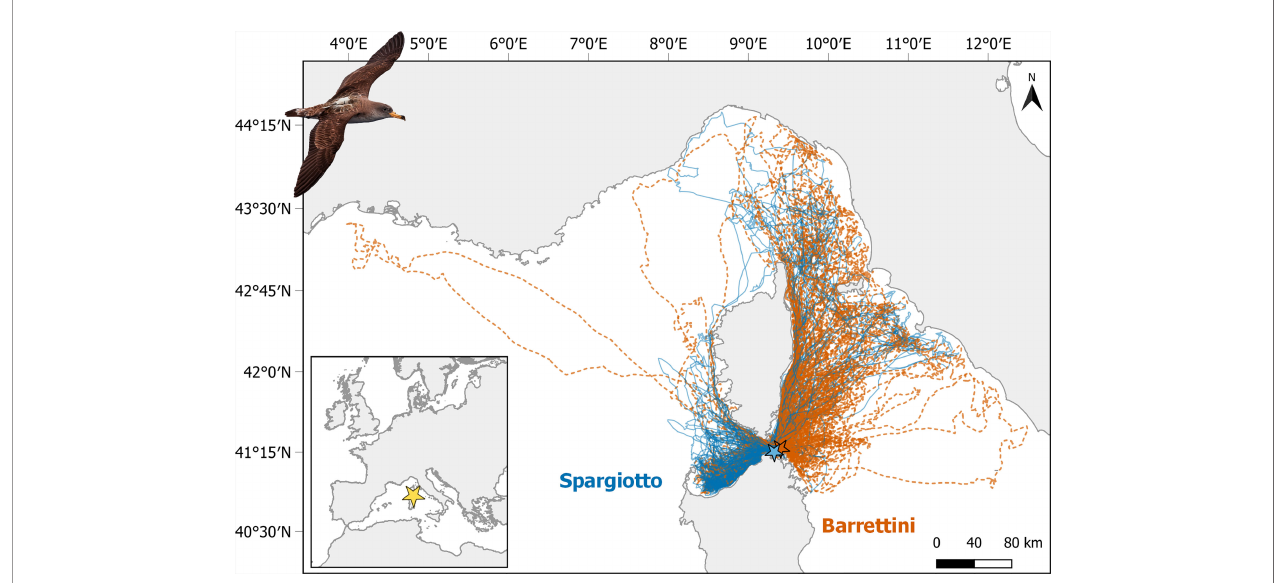
FIGURE 1 | Tracks of foraging trips performed by Scopoli ’ s shearwaters breeding in Spargiotto (solid blue lines) and Barrettini (dashed orange lines) islets in La Maddalena archipelago (Sardinia) in 2013, 2018 and 2019. See Figure S6 for the separation of trips by year. Picture of tagged Scopoli ’ s shearwater courtesy by Mirko